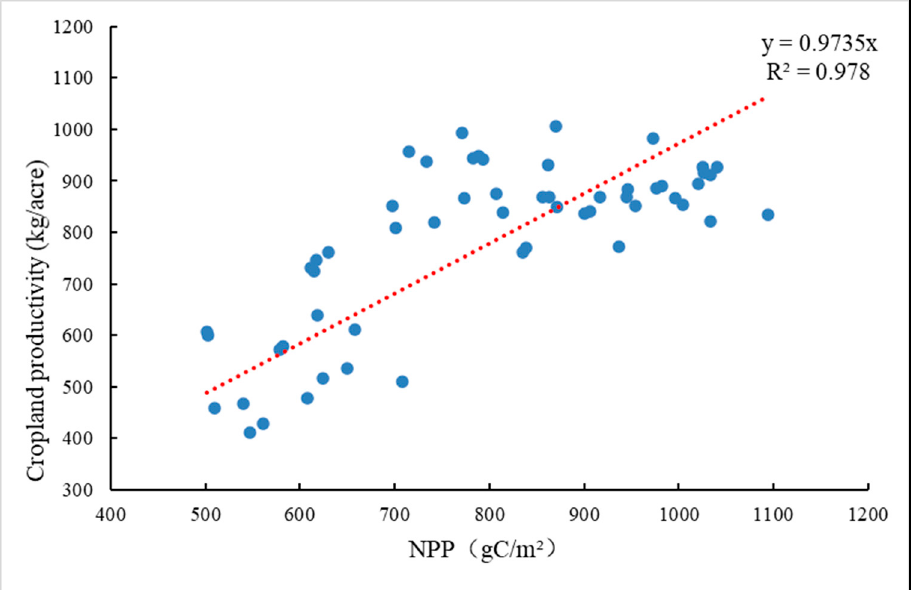
Figure 3. Relationship between NPP of farmland ecosystems and cropland productivity in Henan Province.